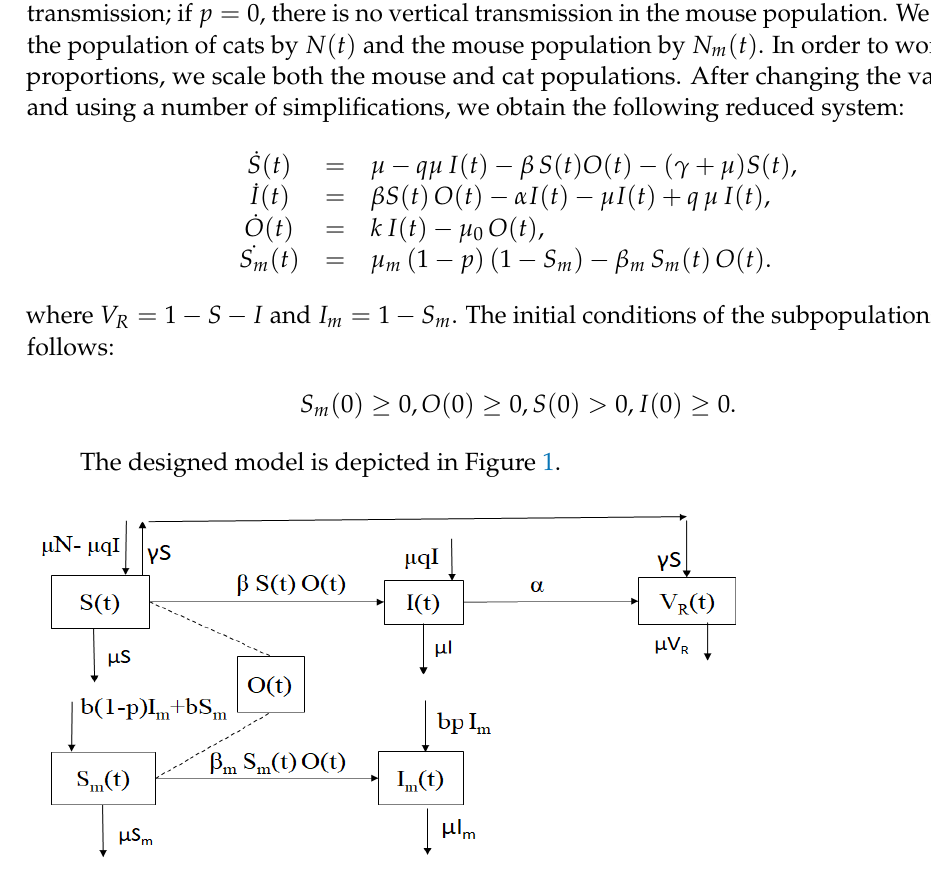
Figure 1. Chart of the mathematical model of generalized toxoplasmosis transmission (1) for mouse and cat populations taking into account generalized vertical